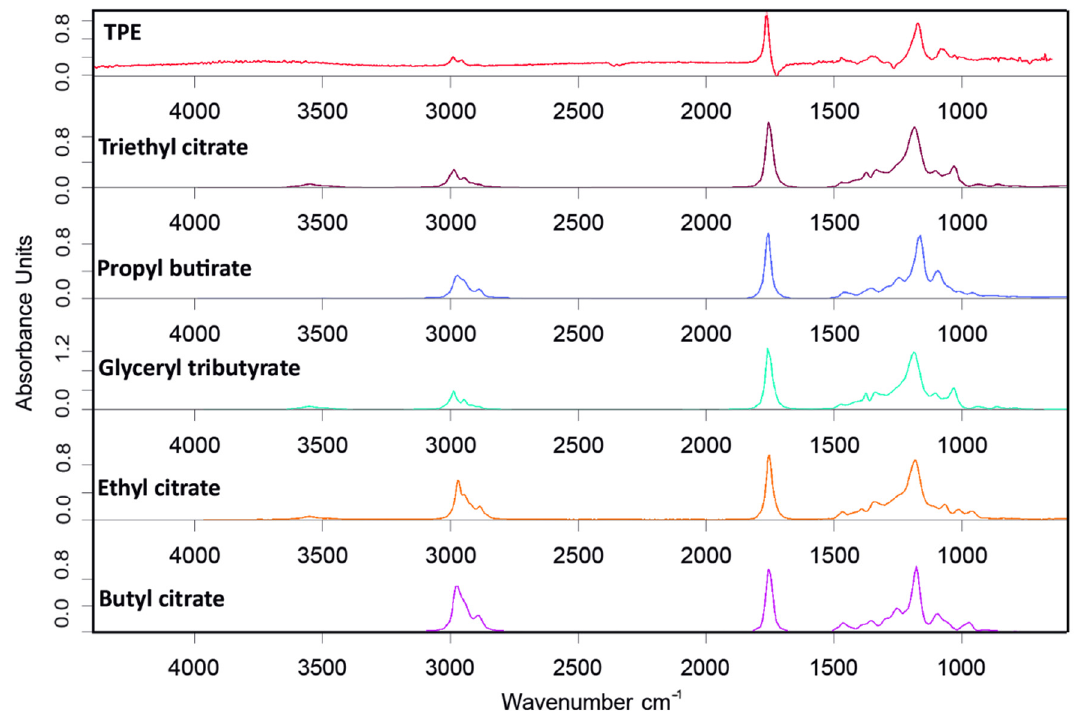
Figure 13. FTIR from TPE degradation at 187 °C and possible compounds that match with the spec- tra.